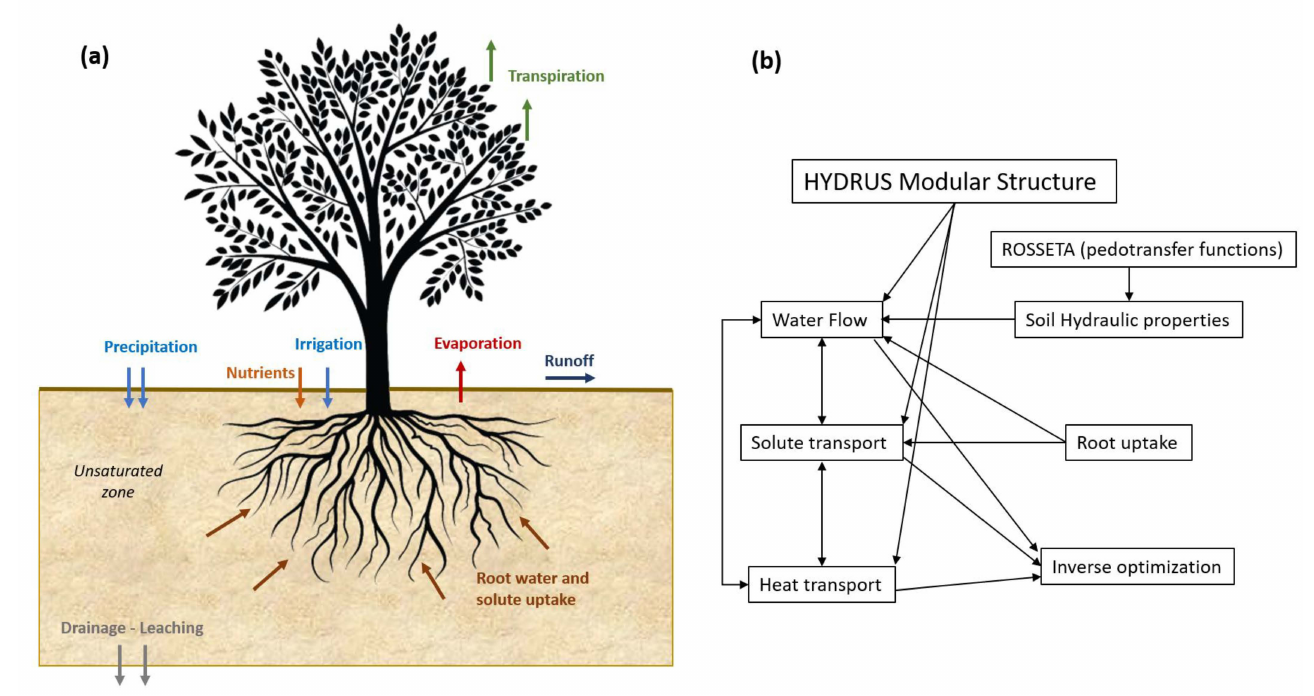
Figure 2. ( a ) Schematic of the main water and solute fluxes and ( b ) schematic of the HYDRUS modular